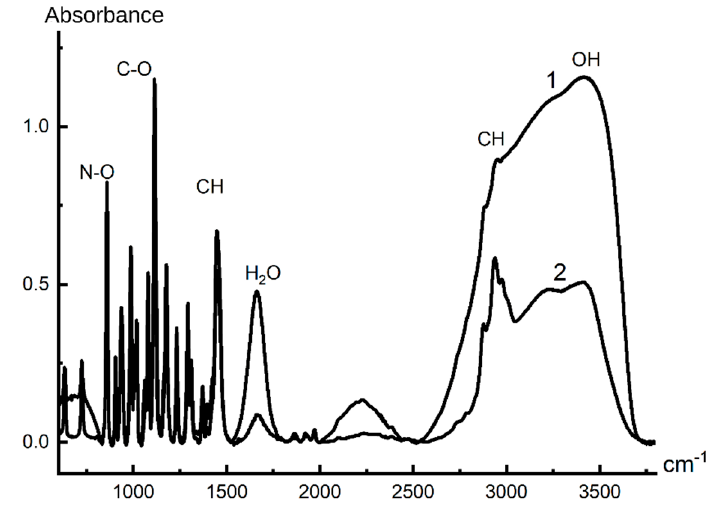
Figure 16. IR spectra of NMMO obtained from: IBA (1); and water (2).